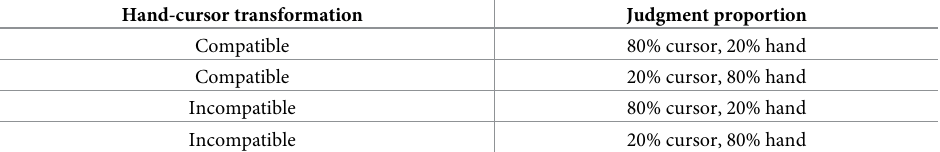
Table 1. Blocks used in the experiment combining the manipulations of hand-cursor transformation and judg- ment proportion. Hand-cursor transformation